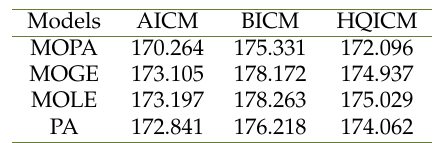
Table 5. The AICM, BICM, and HQICM values for the Turbocharger data.